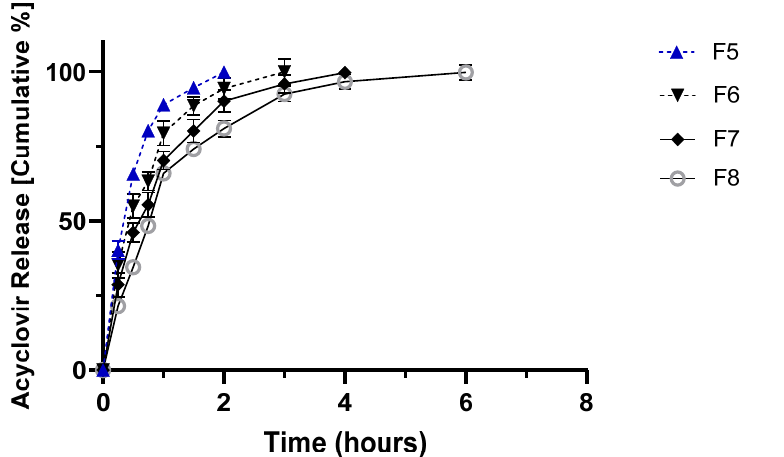
Figure 2. In vitro release profile of acyclovir from HPMC tablets (F-1 to F-4) in 0.1 N HCl (pH 1.2) from zero to two hours, after which 200 mL of 0.2 M sodium phosphate tribasic solution was added to reach a final pH of 7.4 kept for the remaining 24 h. Please refer to Table 7 for tablets’ composition.